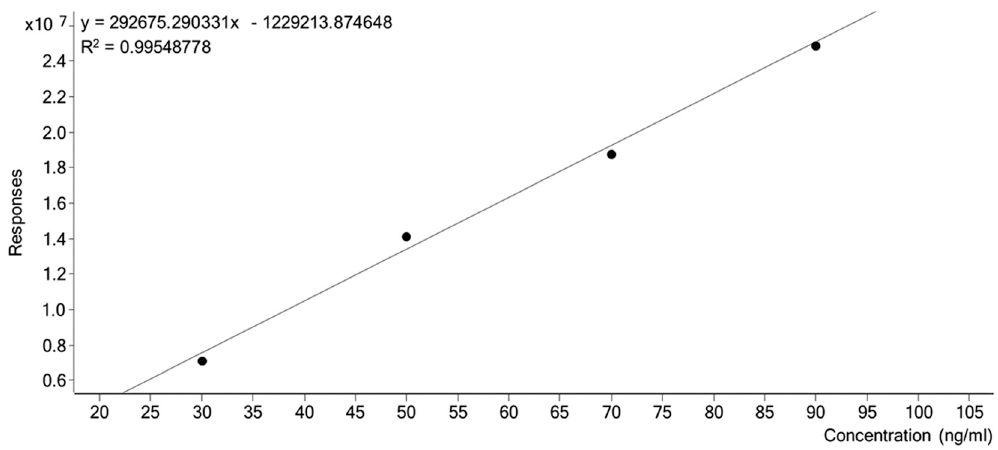
Figure5. TheobtainedcalibrationcurveofCrebytheLC-MSanalysisofthepreparedstandardsolutions. Figure 5. The obtained calibration curve of Cre by the LC-MS analysis of the prepared standard Table 1. Amount of creatinine in the urine samples from three di ff erent patients determined by the solutions. LC-MS method and Ja ff e Table 1. Amount of creatinine in the urine samples from three different patients determined by the LC-MS method and Jaffe test.